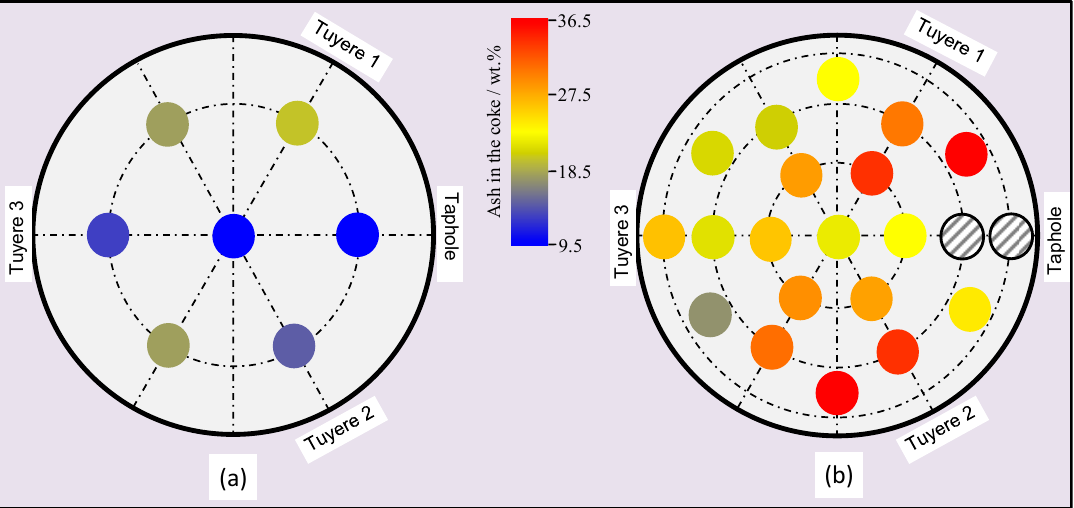
Figure 3. Ash contents in the coke samples collected from the EBF hearth: ( a ) first sampling layer; ( b ) second sampling layer. There is no valid data for the samples collected from the close-to-taphole region, due to the involvement of the taphole clay in the samples.